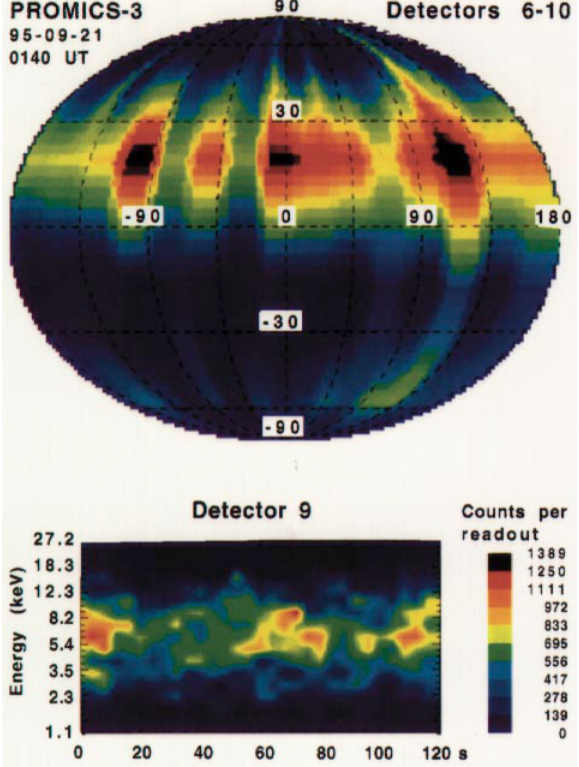
Fig. 13. Ring-shaped proton distribution with gyro bunching meas- ured on 21 September at 0140 UT in the dawnside plasma sheet (SM coordinates: ! 3.5, ! 13.1, ! 2.8). The upper part shows the total number of protons in the energy range 1 — 30 keV as a function of direction of incidence. The lower part shows a spectrogram mea- sured by D9 during one spin. This spectrogram constitutes the contribution from D9 to the upper part of the figure. The scale applies only to the lower